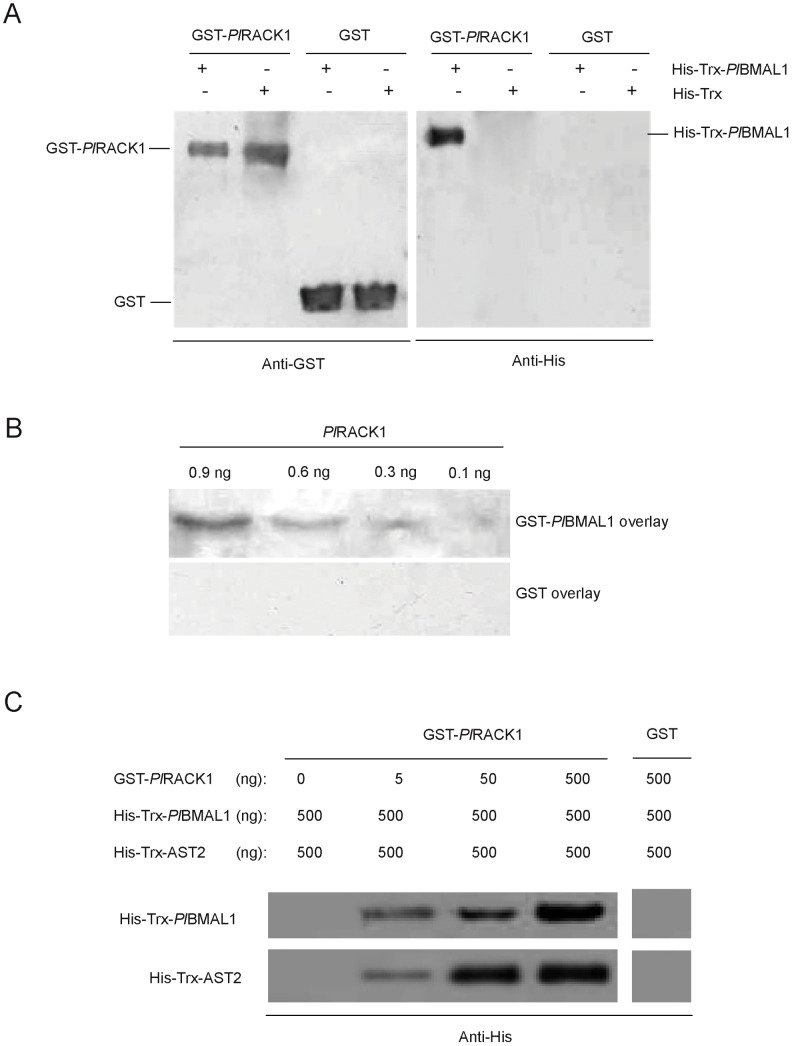

PlRACK1 can bind to PlBMAL1.A) In vitro GST pull-down assay of His-Trx-PlBMAL1 by GST-PlRACK1. The elution fractions of the GST-PlRACK1 pull-down assay were examined by western blot analysis using anti-GST and anti-His antibodies. Lanes 1 and 5: elution fraction of GST-PlRACK1 pull-down of HisTrx-PlBMAL1; Lanes 2 and 6: GST-PlRACK1 pull-down of His-Trx; Lanes 3 and 7: GST pull-down of HisTrx-PlBMAL1; Lanes 4 and 8; GST pull-down of His-Trx. B) The protein-protein interaction of PlRACK1 and PlBMAL1 was analyzed by far western blotting. C) Binding of AST2 and PlBMAL1 to GST-PlRACK1. GST-PlRACK1 (0, 5, 50 or 500 ng) was bound to Glutathione Sepharose beads and incubated with 500 ng His-Trx-PlBMAL1 and 500 ng His-Trx-AST2. Bound proteins were eluted and immunoblotted for PlBMAL1 and AST2 using an anti-His antibody and for PlRACK1 with an anti-GST antibody.